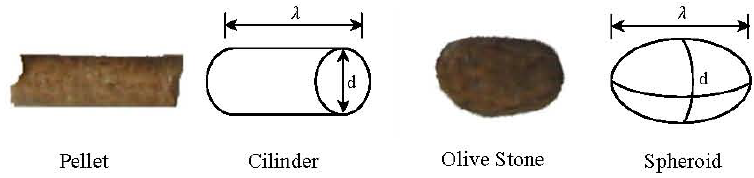
Figure 5. Characteristic shape geometry of each